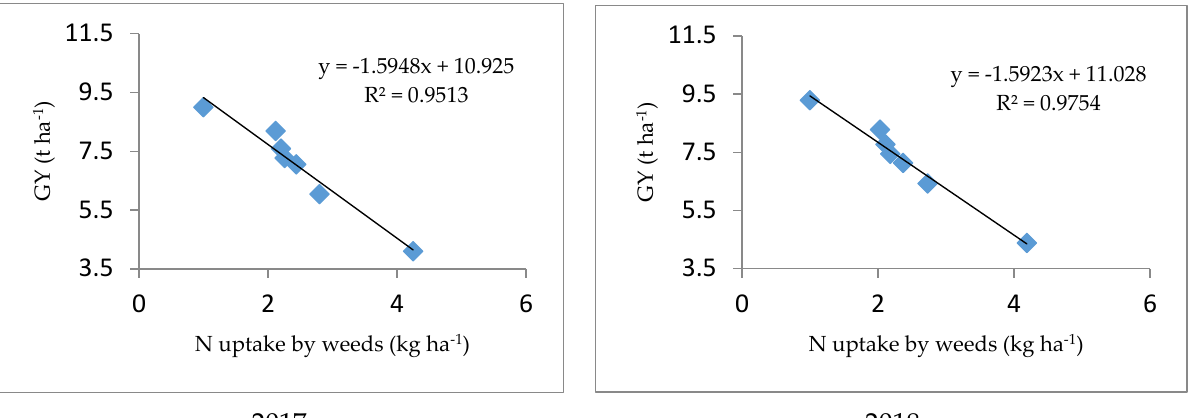
Figure 13. Linear regression line among weed management practices between weed dry matter vs. Grain yield (GY).